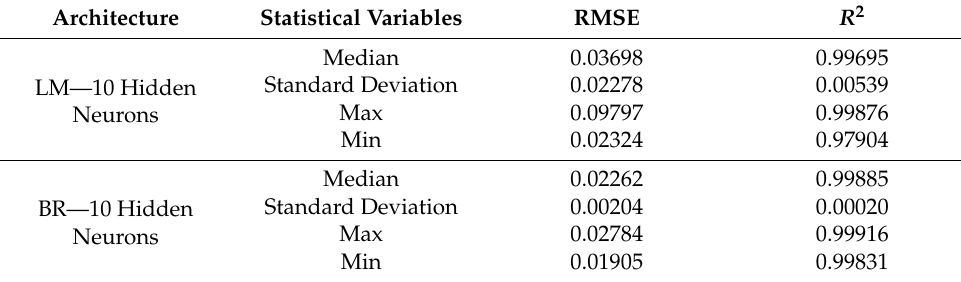
Figure 10. Performance metrics of the BR-trained FFNN2 consisting of 50 hidden neurons. Table 3. Results summary for the geotechnical